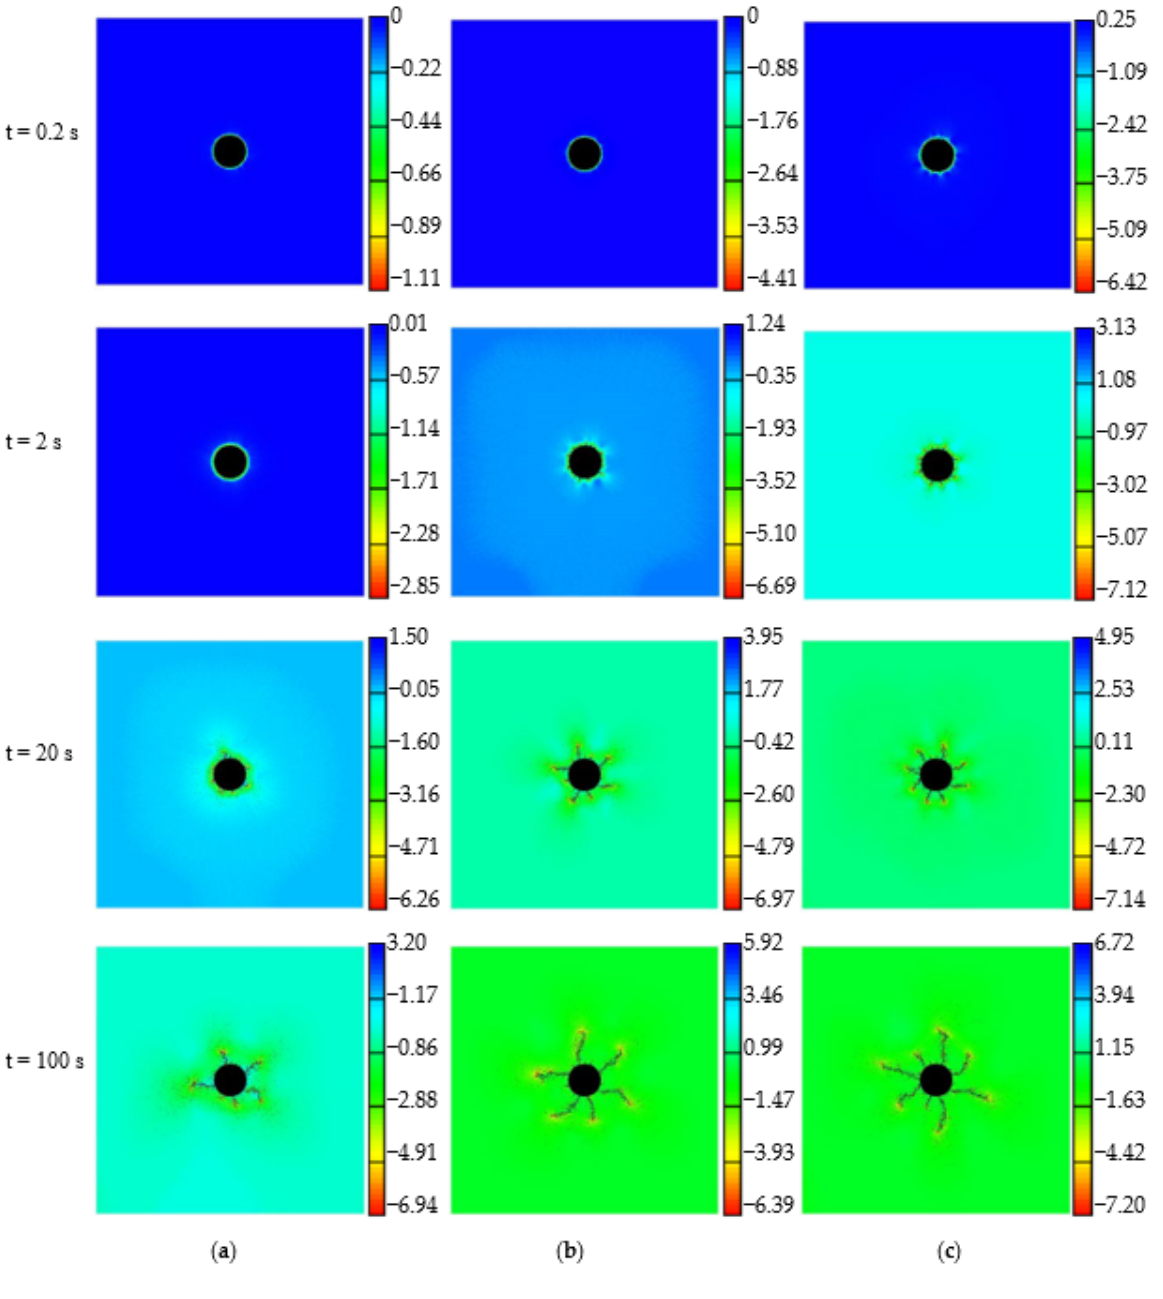
Figure 18. Minimum principal stress and crack propagation process in the circular hole plate models with different heat exchange coefficients (unit: MPa). ( a ) H = 100 12 m −− ⋅⋅ KW